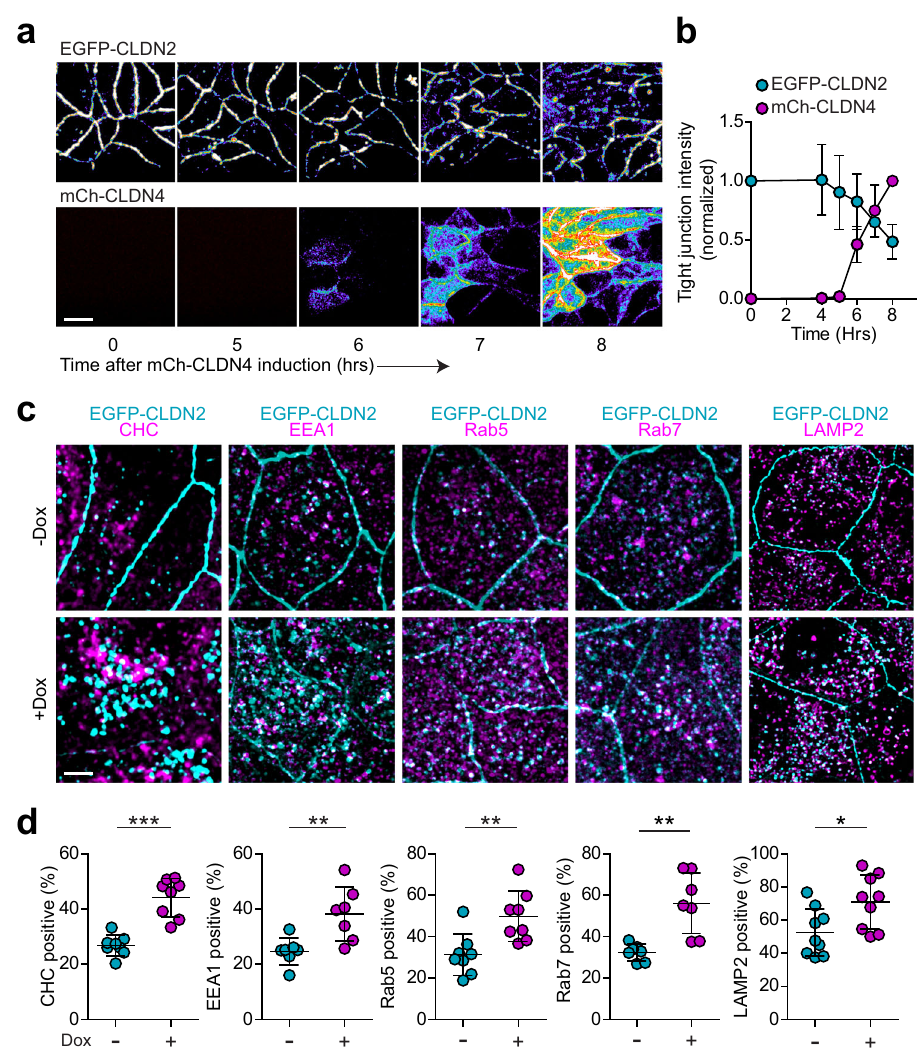
Fig. 8 Claudin-4 expression results in clathrin-mediated endocytosis of claudin-2. a Live imaging demonstrates progressive EGFP-claudin-2 removal from tight junctions and accumulation in intracellular vesicles after induction of mCherry-claudin-4 expression (both claudins shown as pseudocolor to facilitate visualization of the wide range of intensities). Note the relative preservation of junction-associated EGFP-claudin-2 in regions with lower levels of mCherry-claudin-4 expression, e.g., lower right corner of the last image pair. Representative of at least 4 independent experiments. Scale: 10 µ m. b Loss of tight junction-associated EGFP-claudin-2 (cyan symbols) correlates temporally with increased mCherry-claudin-4 (magenta symbols) expression. n = 4, representative of 3 independent experiments. c mCherry-claudin-4 expression (not shown) leads to EGFP-claudin-2 (cyan) endocytosis and colocalization with endocytic markers (magenta) clathrin heavy chain (CHC), EEA1, Rab5, Rab7, and LAMP2. Maximum projection images representative of 3 independent experiments. Scale: 5 µ m. d The fractions of EGFP-claudin-2 vesicles that contain clathrin heavy chain (CHC, n = 8, P < 0.0001), early endosome markers EEA1 ( n = 7, P = .007) and Rab5 ( n = 8, P = 0.005), late endosome marker Rab7 ( n = 7, P = 0.0014), or lysosomal marker LAMP2 ( n = 9, P = 0.021) without claudin-4 ( − Dox, cyan symbols) is increased by mCherry-claudin-4 expression ( + Dox, magenta symbols). Each data point represents 4 – 5 cells, representative of 3 independent experiments. Two-tail unpaired t -test. * P < 0.05, ** P < 0.01, ** P < 0.0001. Data are presented as mean ± SD and included in the Source Data fi